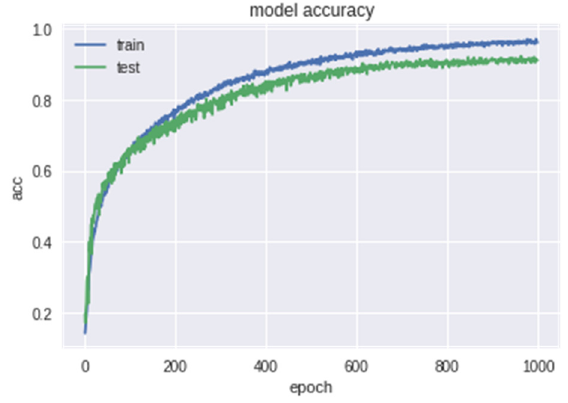
Figure 12. Accuracy of the Model.